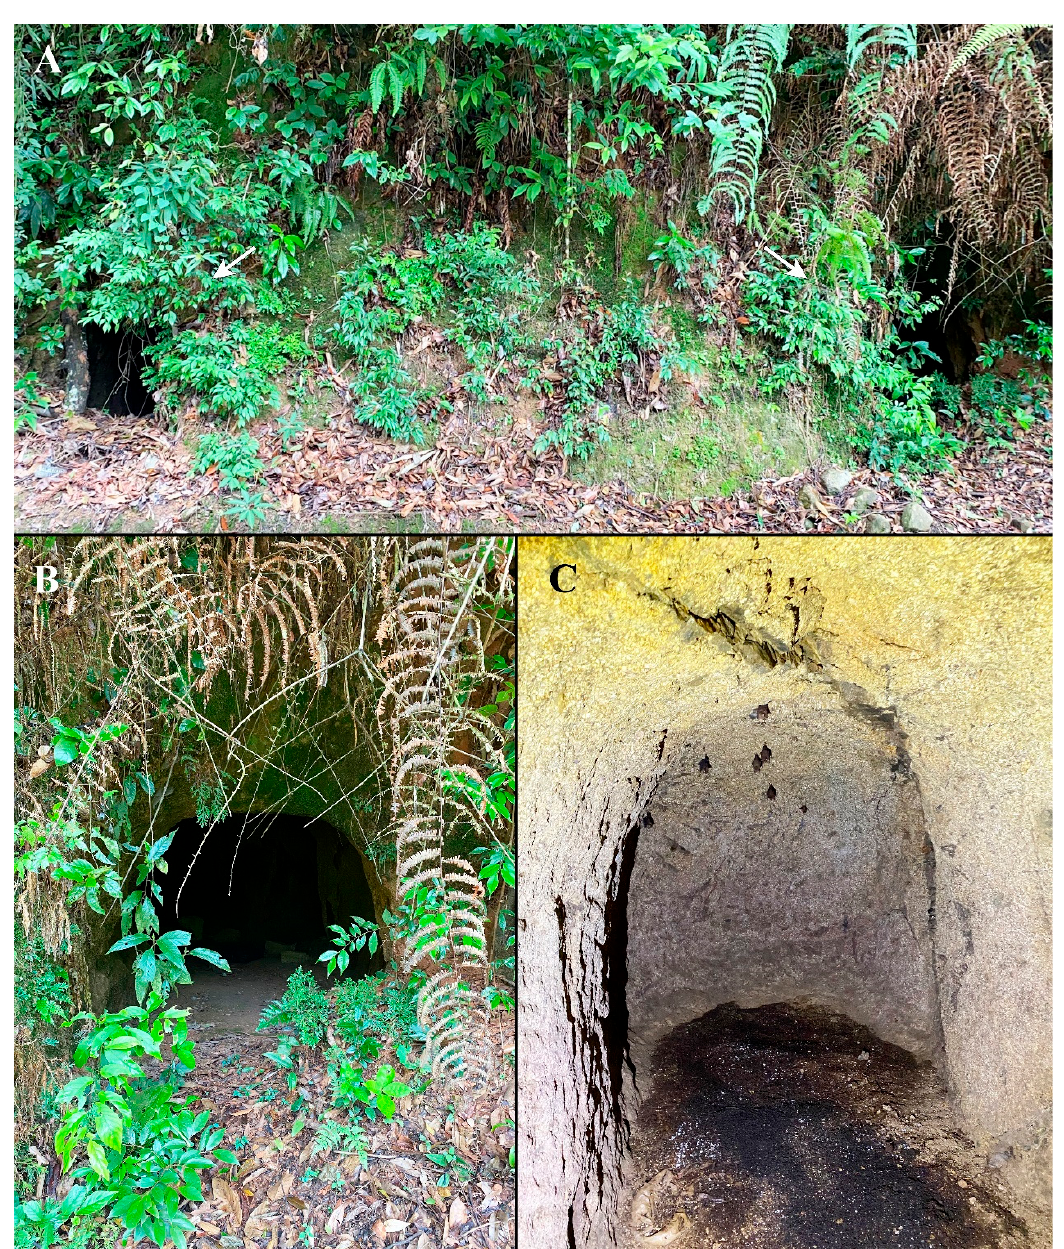
Figure 5. Habitat of Coelops frithii . ( A ). The roadside slope with the two openings (white arrows) to the cave (a former bomb shelter). ( B ). The opening to the right branch of the cave. ( C ). The deepest part of the right